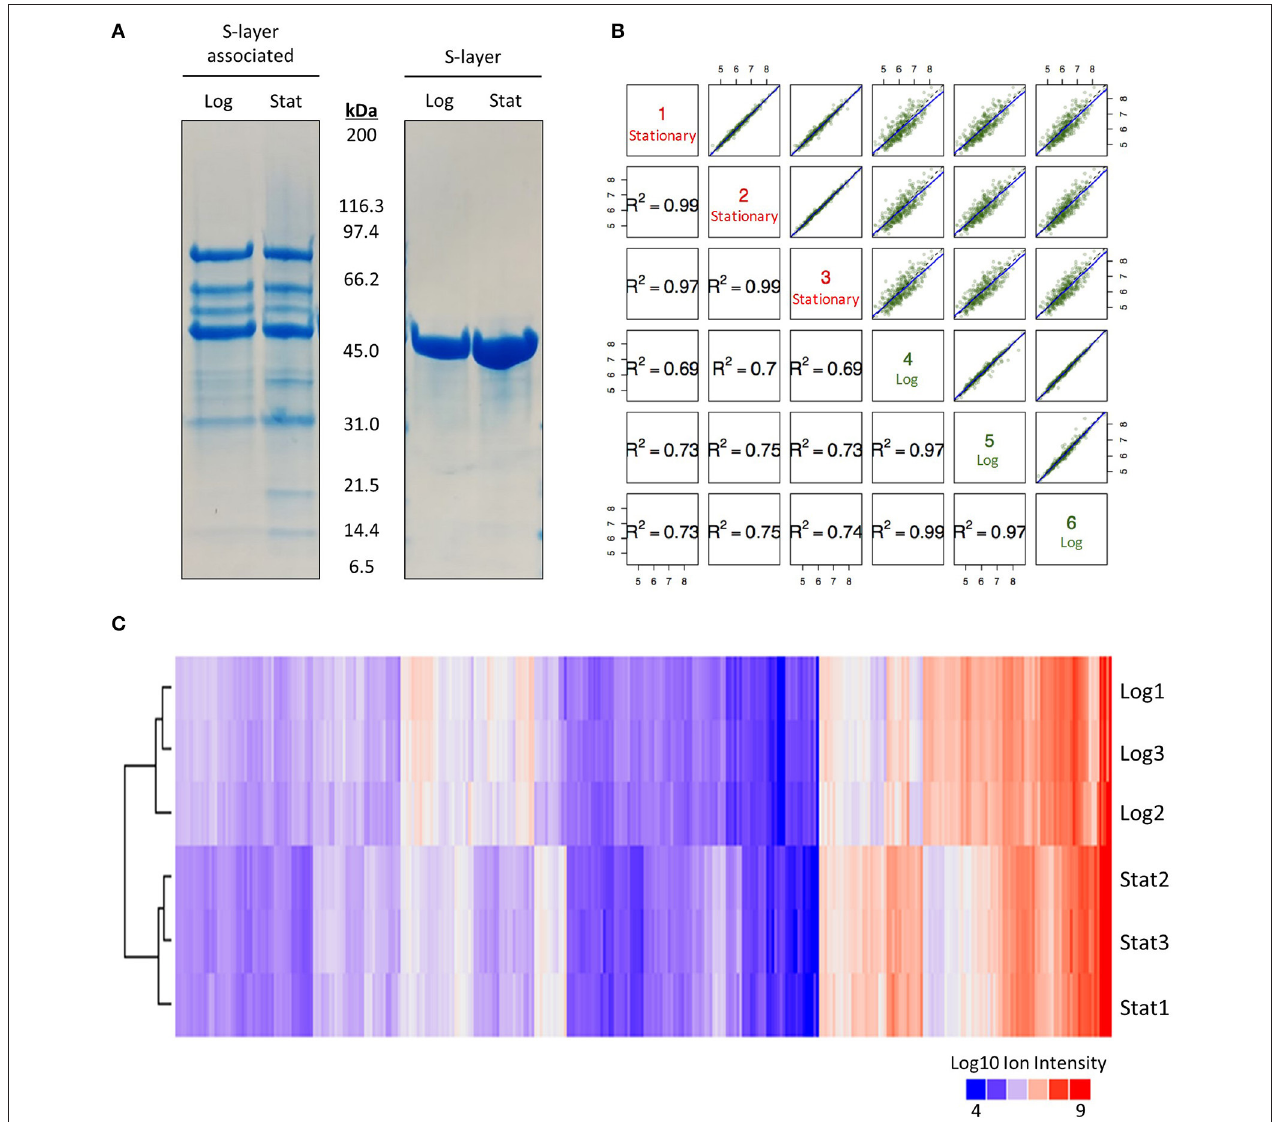
FIGURE 1 | SDS-PAGE and quantitative proteomic results . (A) SDS-PAGE gel used to visualize the effect of growth phase on the S-layer and S-layer associated proteome of Lactobacillus acidophilus NCFM at 6h (log) and 12h (stat). (B) Correlation plot of multiplexing mass spectrometry data for all identified S-layer associated proteins in logarithmic and early stationary growth phases. (C) Clustering of Log10 ion intensities for all identified proteins in logarithmic and early stationary growth